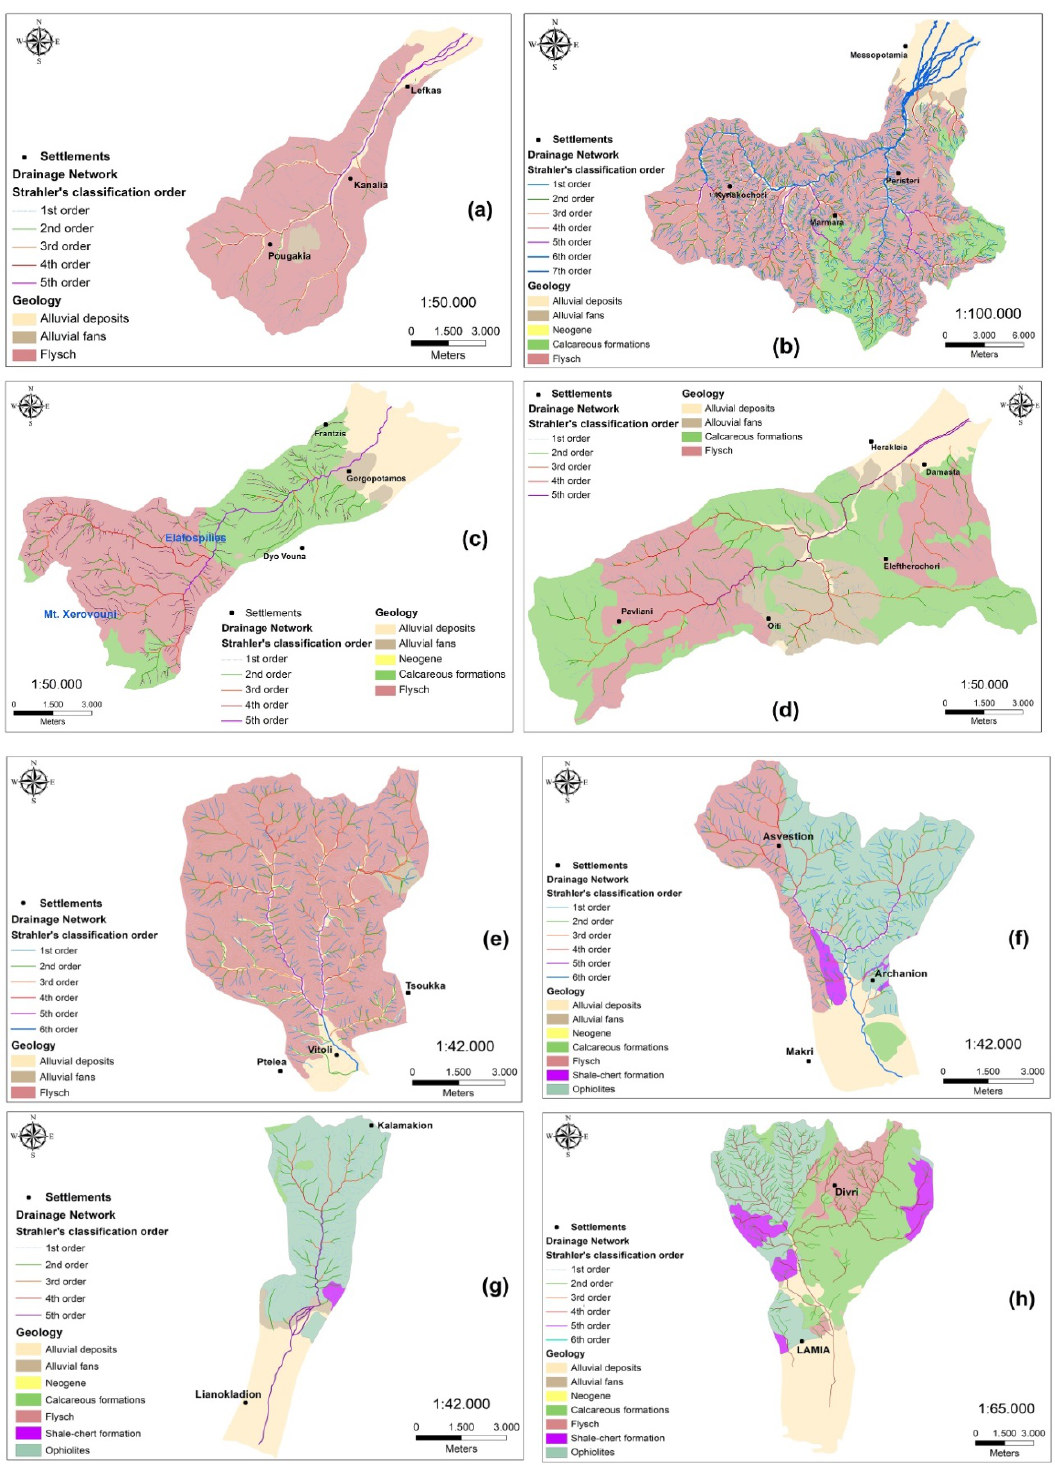
Figure 6. The geology and the classified drainage formation of ( a ) Roustianitis ( b ) Inachos, ( c ) Gorgopotamos, ( d ) Assopos, ( e ) Vitoliotis, ( f ) Archanorema, ( g ) Drimarorema and ( h ) Xirias catchments.